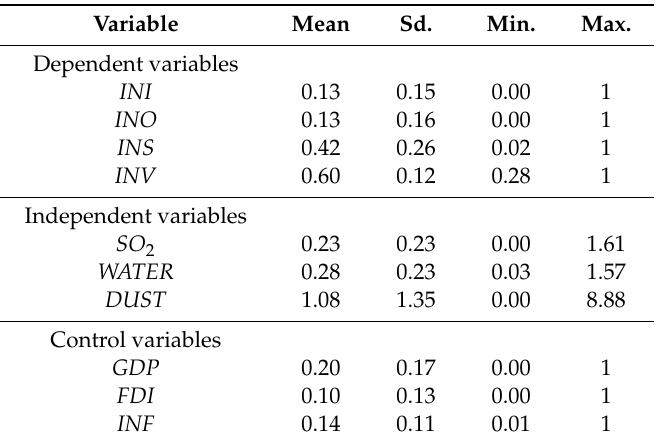
Table 1. Summary statistics for variables used for regressions.